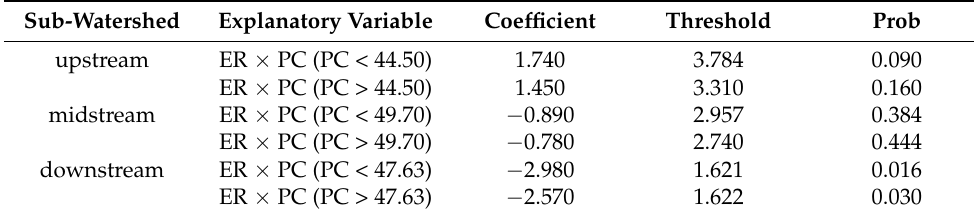
Table 6. Regression results of threshold core variables in sub-basin threshold